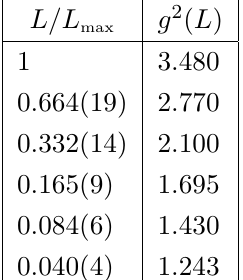
Table 16 . Values of the running coupling as a function of L , in units of the length scale L de(cid:12)ned by the condition g 2 ( L